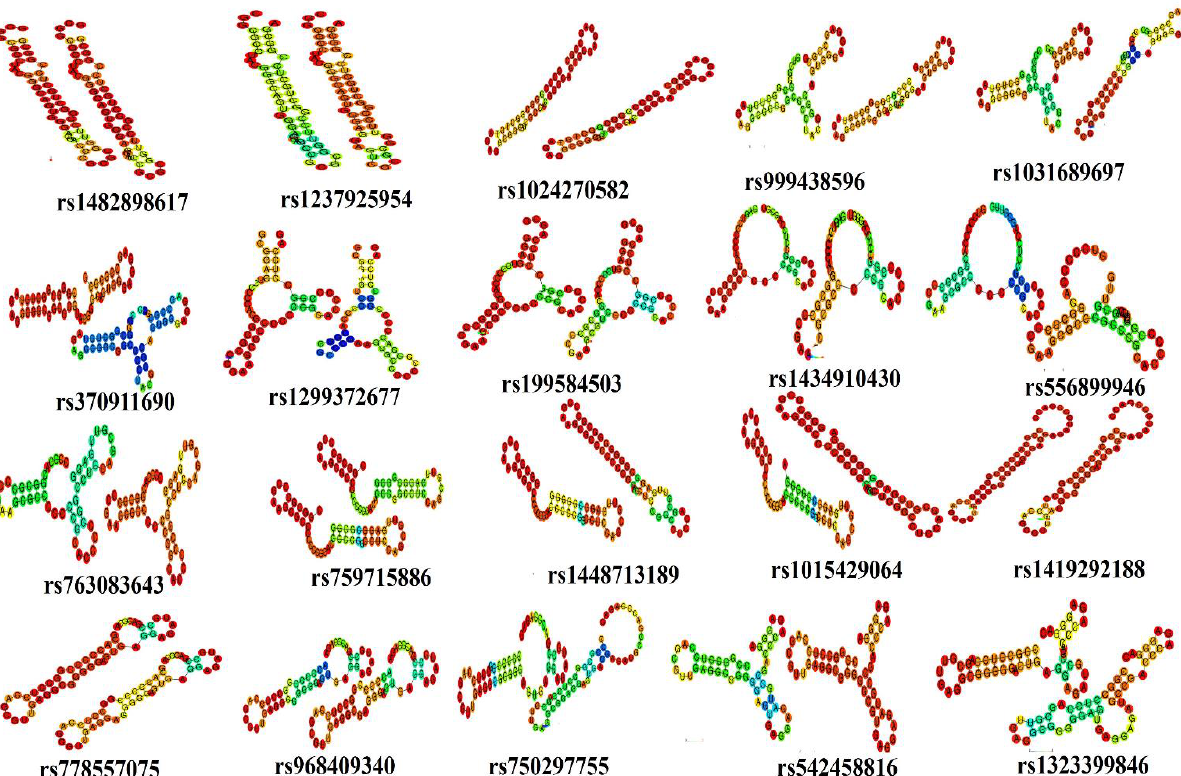
(cid:48) UTR SNPs through RNA